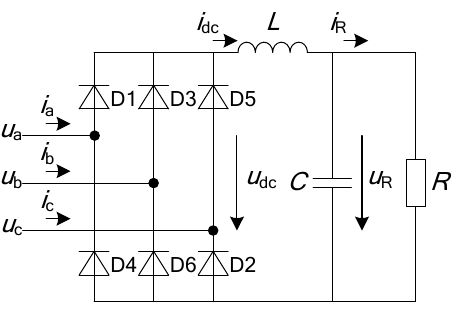
Figure 1. Equivalent circuit for charger.